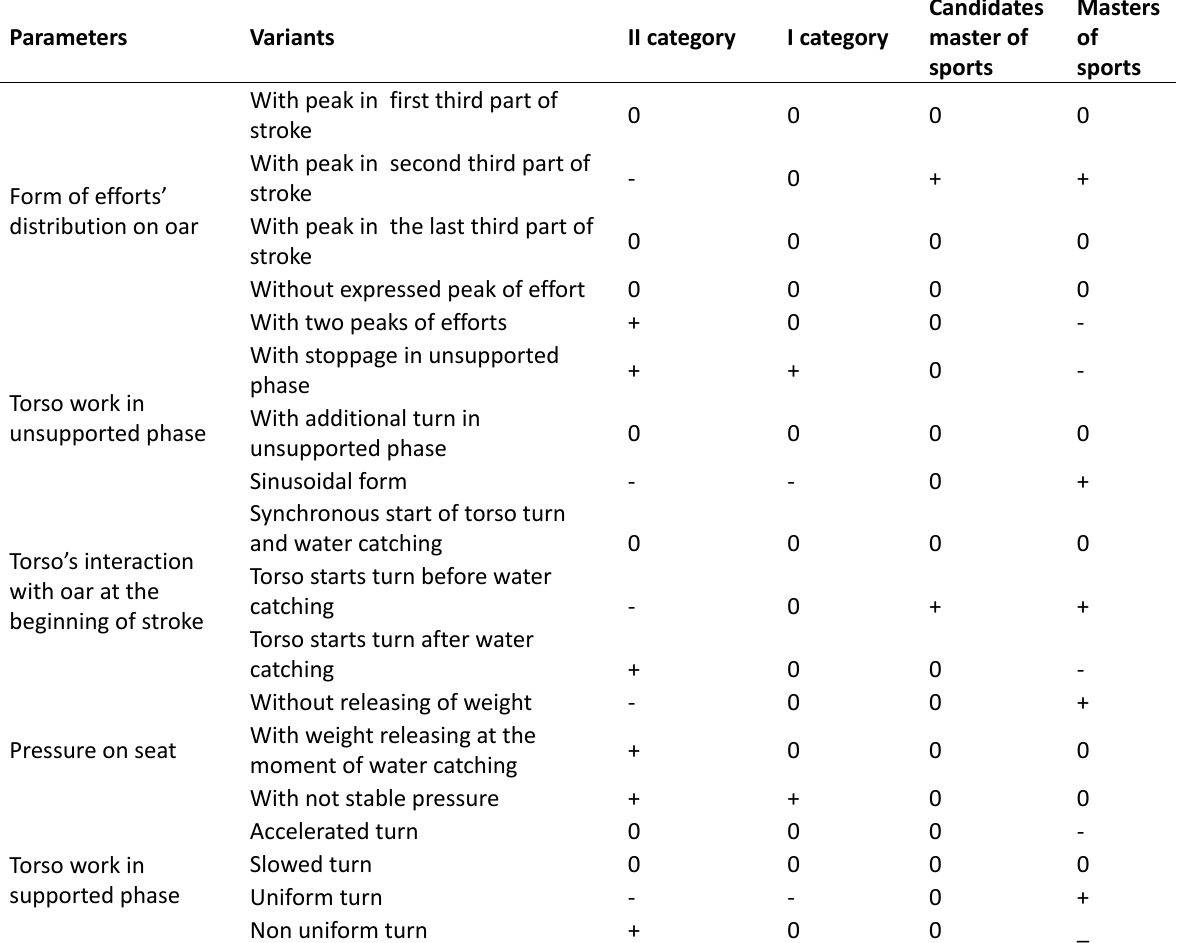
Table 1. Distribution of interconnections between variants of technique’s parameters and rowers’ qualification